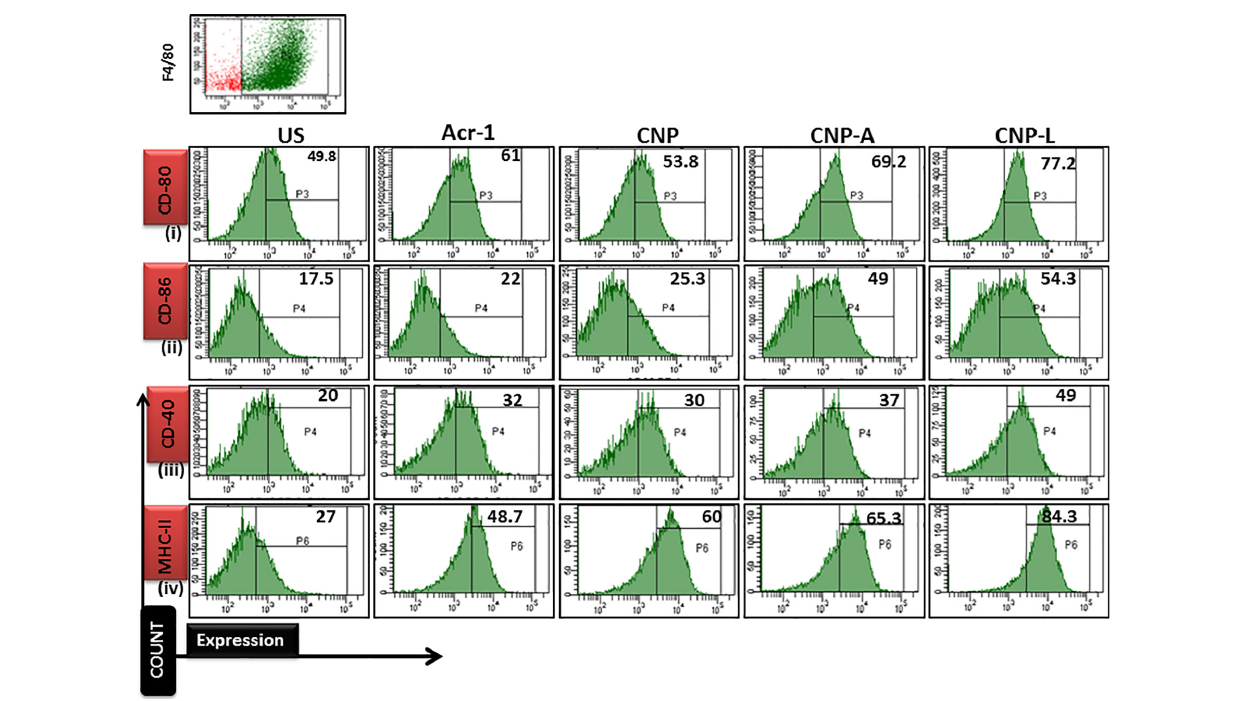
FIGURE 9 | Flow cytometry analysis of co-stimulatory molecule in M. smegmatis infected macrophages cell line: post 24 h treatment with all CNP, CNP-A, and CNP-L groups, infected macrophages cell were acquired and checked for costimulatory molecule expression by FACS analysis. (i–iv) showed that CNP-L group are more efficient to enhance upregulated expression of co-stimulatory molecule CD-40/80/86/MHC-II, expressed on M. smegmatis infected macrophage cell as compared to CNP and CNP-A group.